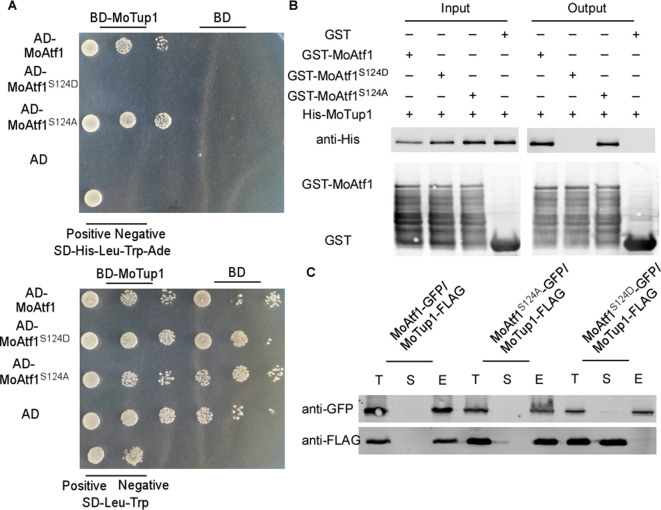
Phosphorylation of MoAtf1 on S124 blocks MoAtf1 and MoTup1 interaction.(A) Y2H analysis of the interaction between MoAtf1 and MoTup1. The pGADT7 and pGBKT7 fused with specific genes were co-introduced into the yeast AH109 strain, and transformants were plated on SD-Leu-Trp as control and on selective SD-Leu-Trp-His-Ade for 3 days. The pair of plasmids pGBKT7-Lam and pGADT7-T were used as the negative controls. The pair of plasmids pGBKT7-(53+) and pGADT7-T was used as the positive controls. (B) The interaction between MoAtf1, MoAtf1S124A, MoAtf1S124D, and MoTup1 in vitro. In vitro GST-pull down assays to confirm the interaction among MoAtf1-MoTup1, MoAtf1S124A-MoTup1, and MoAtf1S124D-MoTup1 pairs. (C) The MoAtf1-GFP, MoAtf1S124A-GFP, MoAtf1S124D-GFP, and MoTup1 were pulled down using anti-GFP agarose beads in vivo and then subjected to SDS-PAGE followed by immunoblotting. T: total protein; S: suspension; E: Elusion.